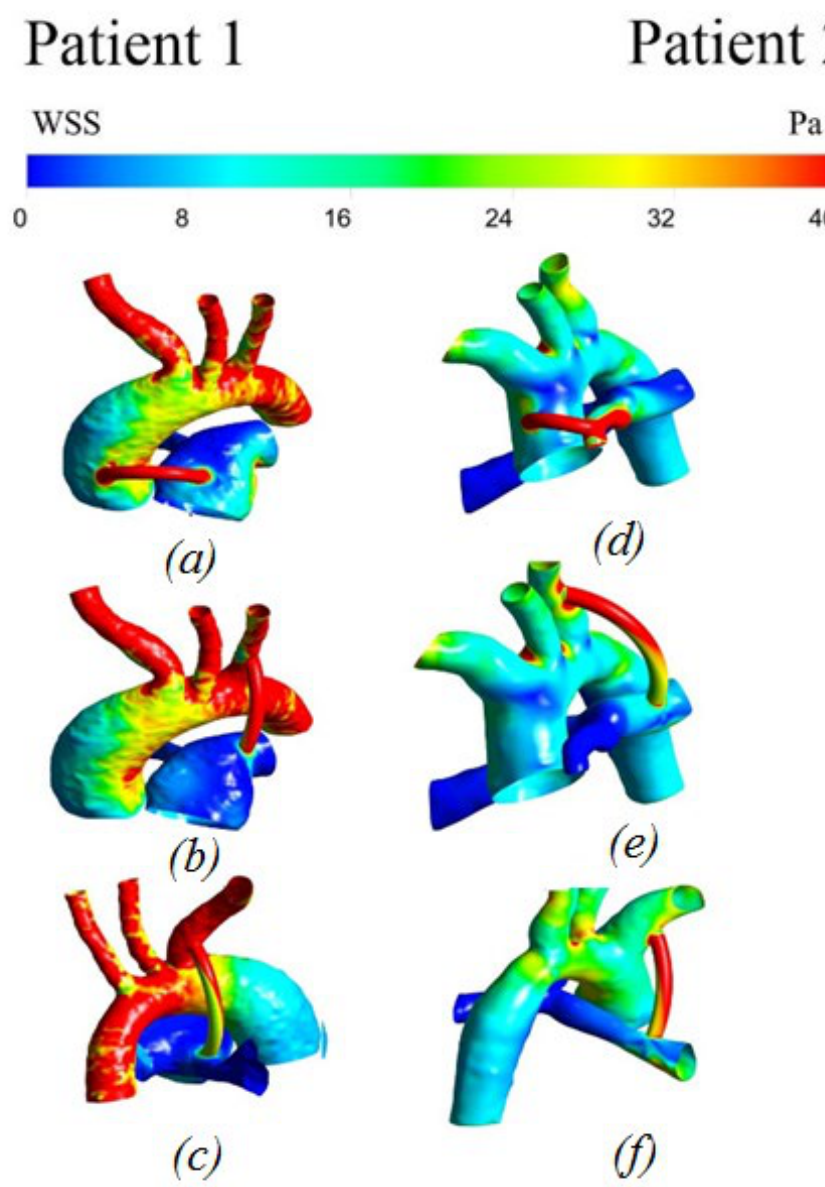
Figure 8. Distribution of wall shear stress with anisotropic properties of the aorta and hyperelastic properties of the shunt: ( a , d ) central shunt; ( b , e ) right shunt; ( c , f ) left shunt.